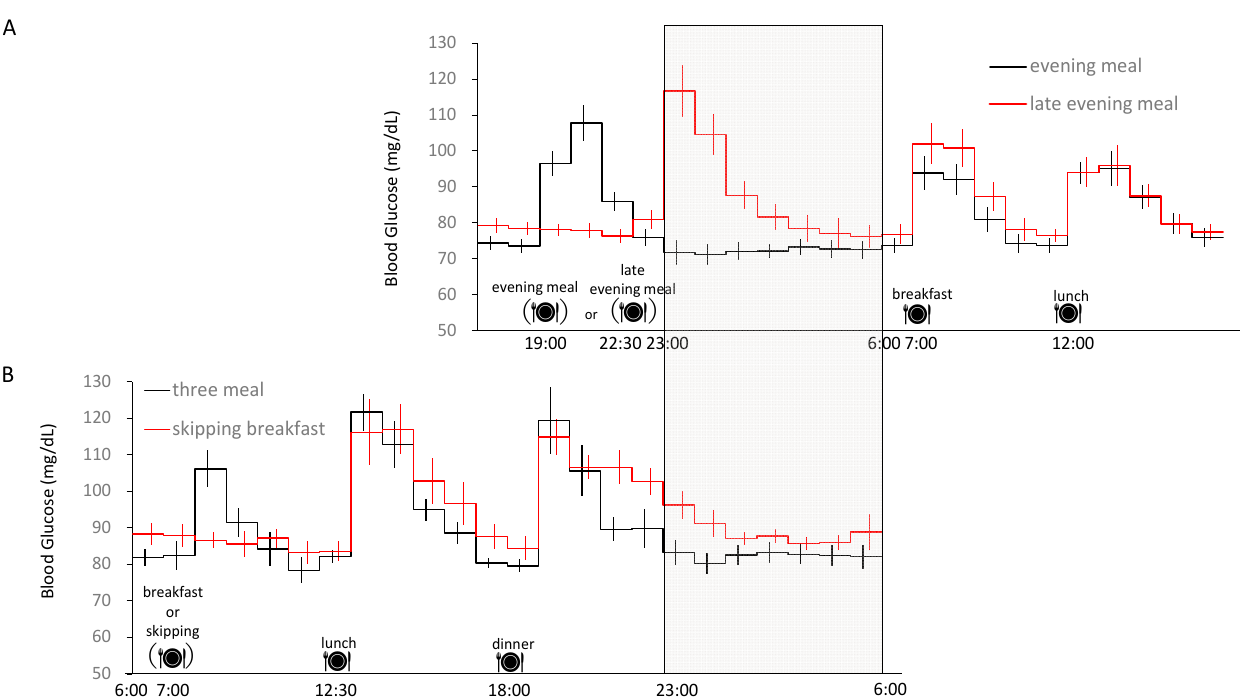
Figure 1. Twenty-four-hour blood glucose profile. Time course of blood glucose for ( A ) ordinary (19:00) and late-evening meal (22:30) [7], and ( B ) skipping breakfast [9], as assessed by a continuous glucose monitoring system. Bedtime (23:00) and wake-up time (6:00) were identical in the two studies. The 24 h energy intake within each study was matched (i.e., the caloric intake of lunch and dinner was increased to compensate for the skipped breakfast). The gray area indicates sleep time, and bedtime (23:00) is shown in vertical rows. Partially modified from [7,9].